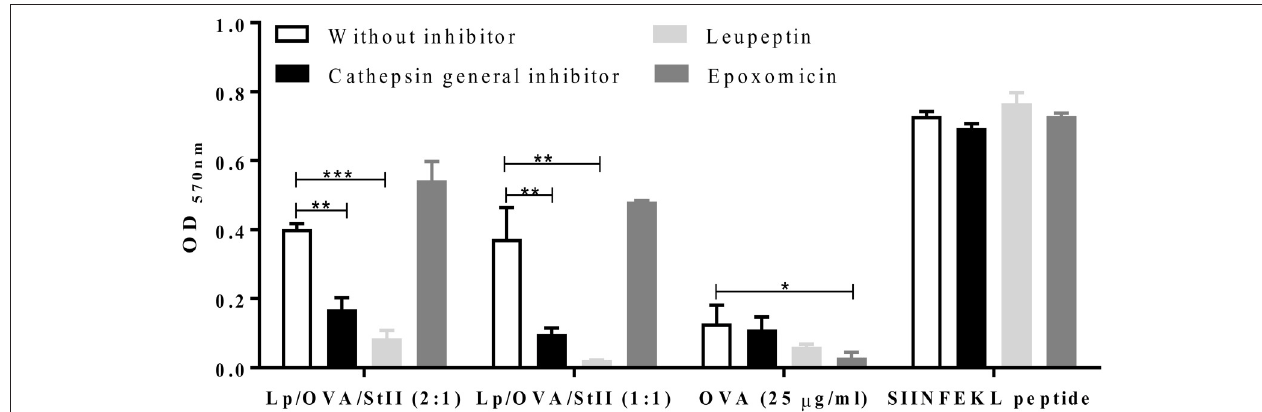
FIGURE 4 | Lysosome proteases but not proteasome inhibitors decrease antigen cross-presentation induced by StII co-encapsulated with OVA into liposomes. Bone marrow-derived macrophages (BM-M 8 s) from C57BL/6 mice were pre-incubated or not with 50 µ M of lysosome protease inhibitors, leupeptin, and a cathepsin general inhibitor or with 1 µ M of the proteasome inhibitor epoxomicin and stimulated with OVA co-encapsulated with StII into liposomes composed DPPC and Chol in 2:1 or 1:1 ratios [Lp/OVA/StII (2:1) or Lp/OVA/StII (1:1)] at final concentrations of 0.8 and 0.1 µ g/ml of each protein, respectively. Cells stimulated with 25 µ g/ml of OVA in soluble form and 10nM of the SIINFEKL peptide were used as controls. Cells were washed and co-cultured with B3Z CD8 + T cells. β -galactosidase activity of the B3Z cells was determined by a colorimetric assay. Mean and SEM of OD 570nm of two independent experiments are shown. Statistical analysis was performed with the one-way ANOVA test with Dunnett post-test: * p < 0.05, ** p < 0.01, *** p < 0.001.